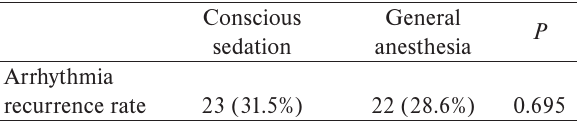
Table 5. Arrhythmia recurrence rate after catheter